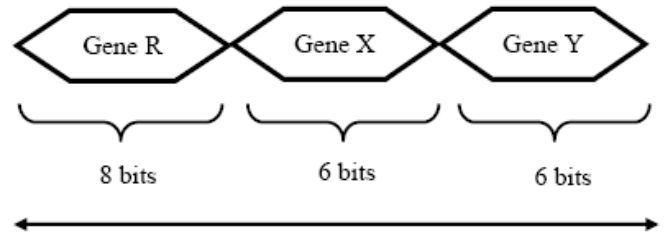
Figure 3. Chromosome encoding